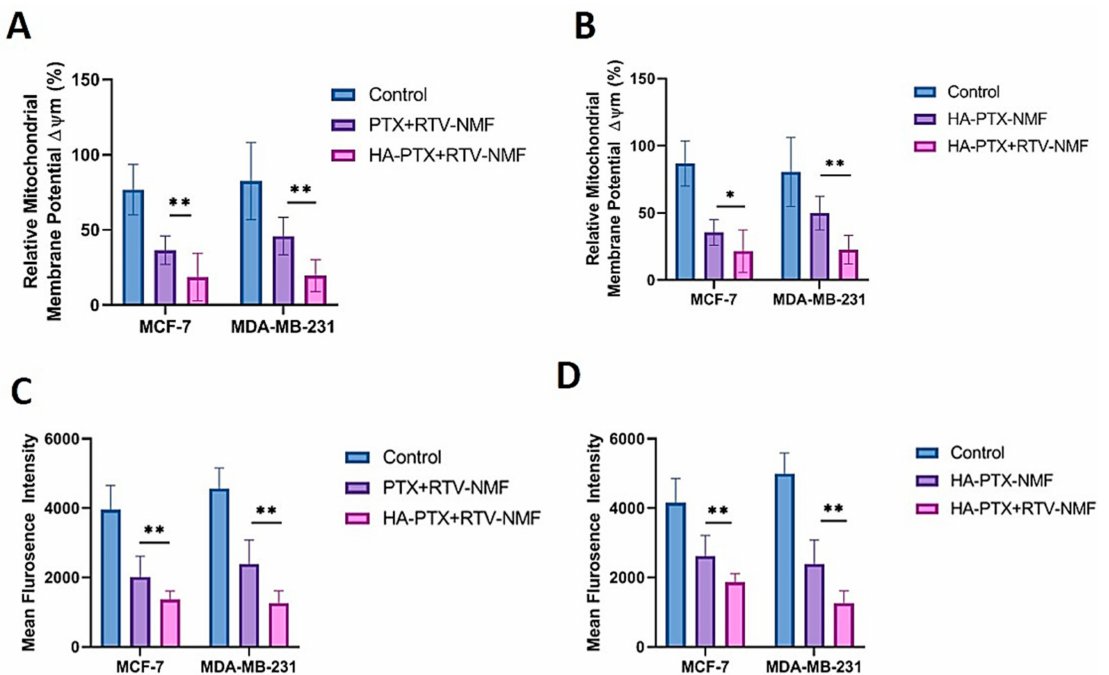
Figure 13. In vivo potency determination of HA − PTX + RTV − NMF. ( A ) Difference in mitochondrial membrane potential ∆Ψ m (JC-1 Red/Green ratio) in MCF-7 and MDA-MB-231 breast cancer cell lines treated with nanomicellar formulations like (i) HA − PTX + RTV − NMF and (ii) PTX + RTV − NMF treated for 24 h. ( B ) Difference in mitochondrial membrane potential ∆Ψ m (JC-1 Red/Green ratio) in MCF-7 and MDA-MB-231 breast cancer cell lines treated with nanomicellar formulations (i) HA − PTX + RTV − NMF and (ii) HA − PTX − NMF treated for 24 h. ( C ) Determination of reactive oxygen species (ROS) in MCF-7 and MDA-MB-231 breast cancer cell lines treated with (i) HA − PTX + RTV − NMF and (ii) PTX + RTV − NMF for 24 h. ( D ) Determination of ROS in MCF-7 and MDA-MB-231 breast cancer cell lines treated with (i) HA − PTX + RTV − NMF and (ii) HA − PTX − NMF for 24 h. The data were expressed as mean ± SD ( n = 3). (* p ≤ 0.05 and ** p ≤ 0.01 as compared to PTX + RTV − NMF/ HA − PTX − NMF